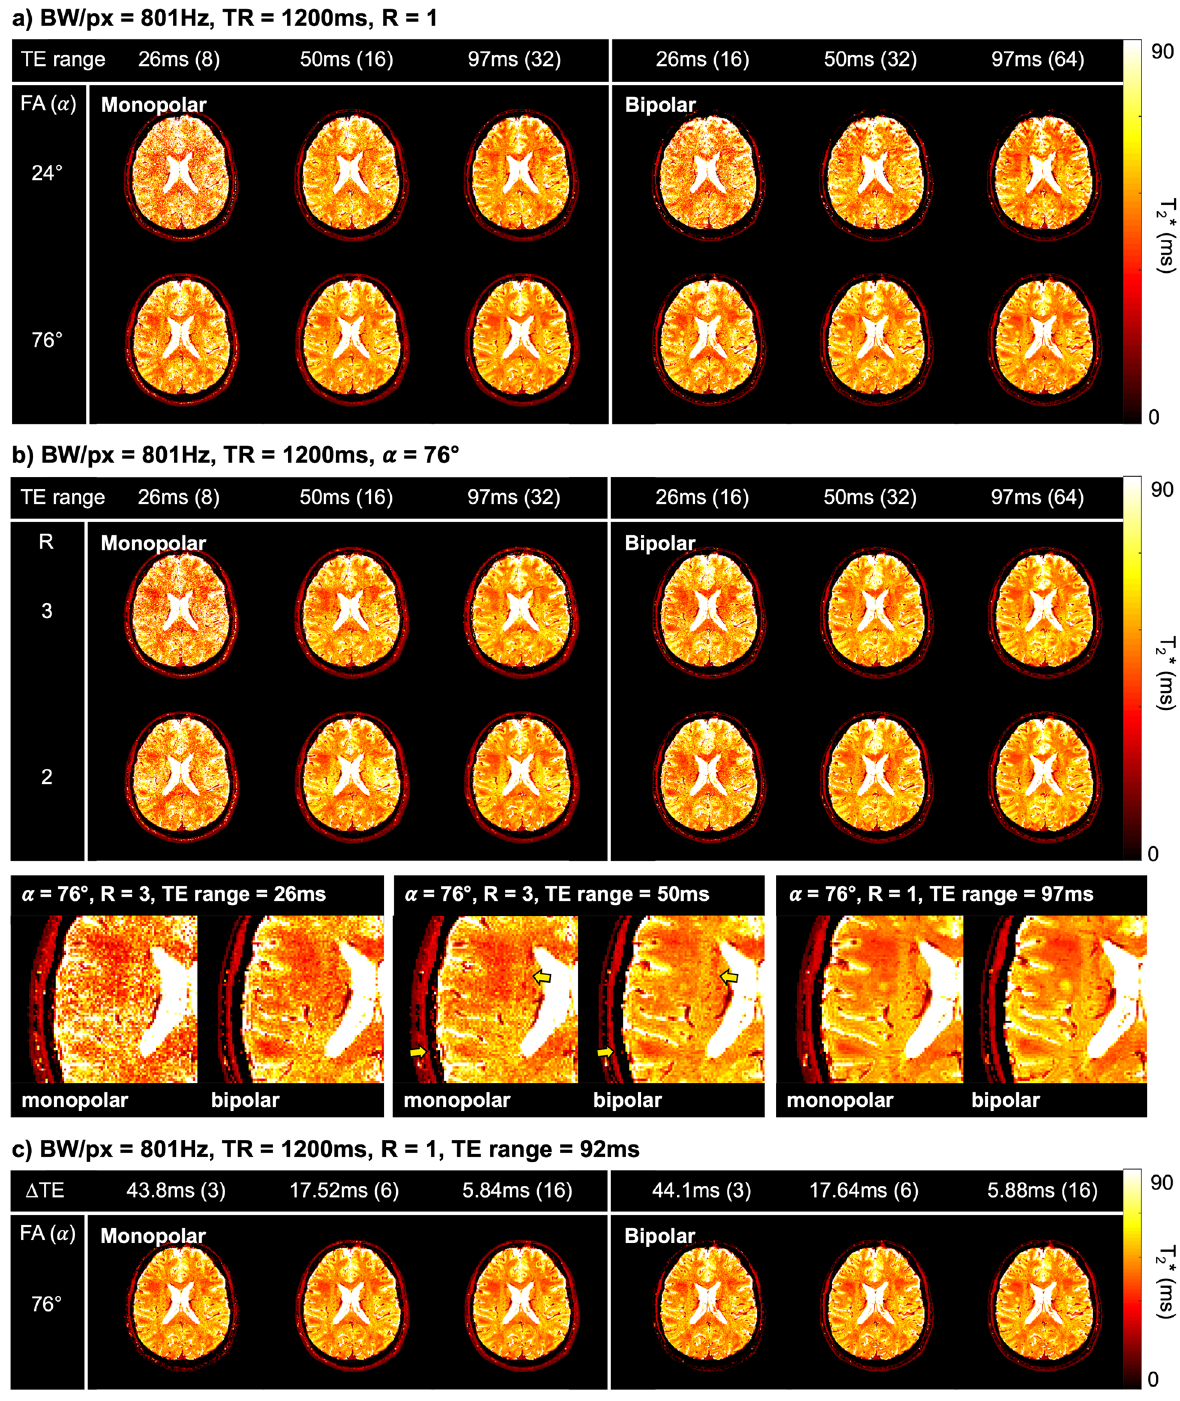
Figure 4. T2* maps from a healthy volunteer obtained using monopolar and bipolar readout gradients with amplitude modulation correction. Each column and row display the results for a different set of ( a ) α and TE range and ( b ) R and TE range. Imaging parameters: BW/px = 801, ∆TE = 2.92 ms for monopolar readout and 1.47 ms for bipolar readout. The number in parentheses is the maximum number of echoes achieved in the given TE range. As indicated by the yellow arrows in the magnified view, anatomical structures are clearly distinguished in the T2* maps from bipolar readouts. The figures in ( c ) show the results for a different set of